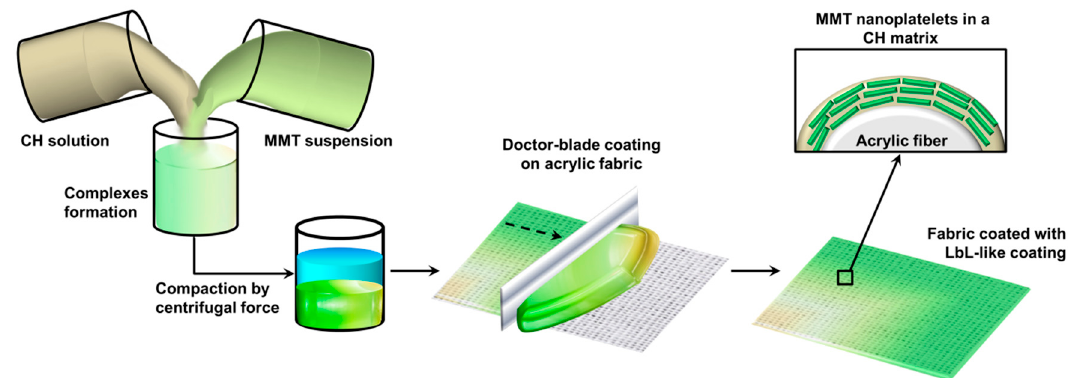
Figure 1. Schematic description of the process adopted to coat acrylic fabric: chitosan (CH) solution and montmorillonite (MMT) suspension are mixed in controlled conditions and then centrifuged, the resulting gel-like precipitate is then doctor-bladed on the fabrics.